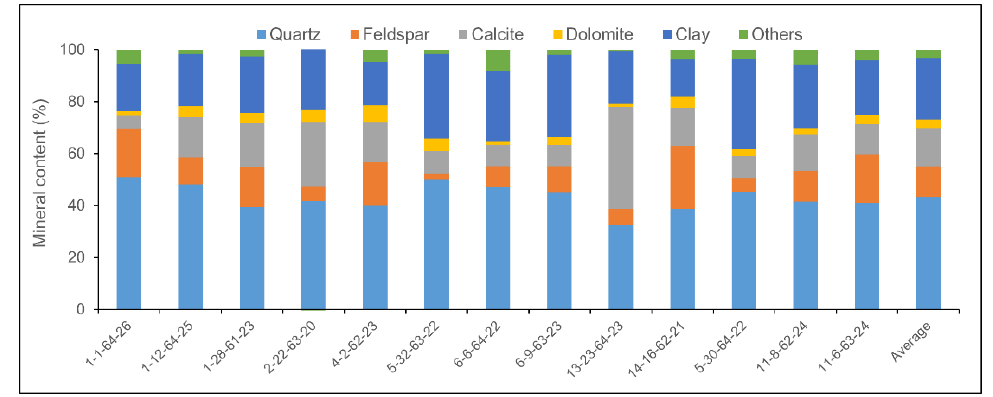
Figure 5. Mineralogy measurements for coring wells. Clay, quartz, feldspar, and calcite are primary